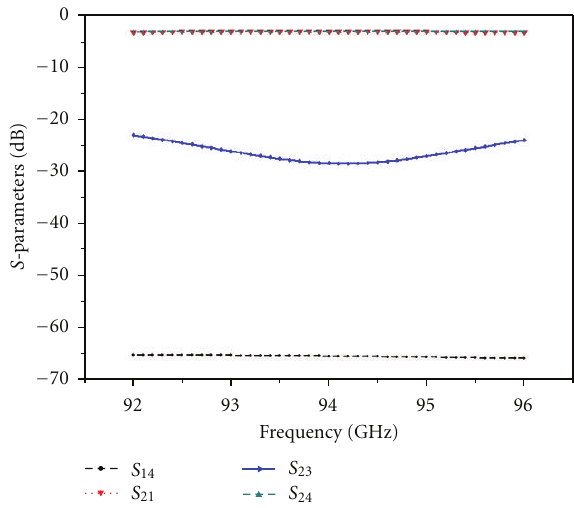
Figure 6: E-FMT isolation and transmission coe ffi cients.